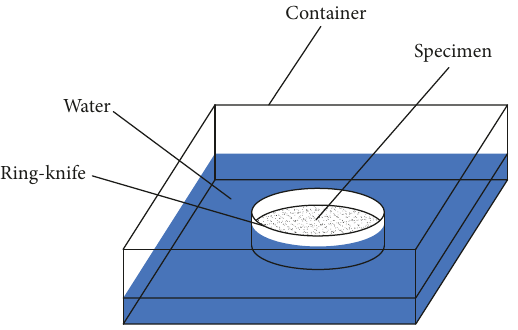
Figure 2: The schematic diagram of water stability